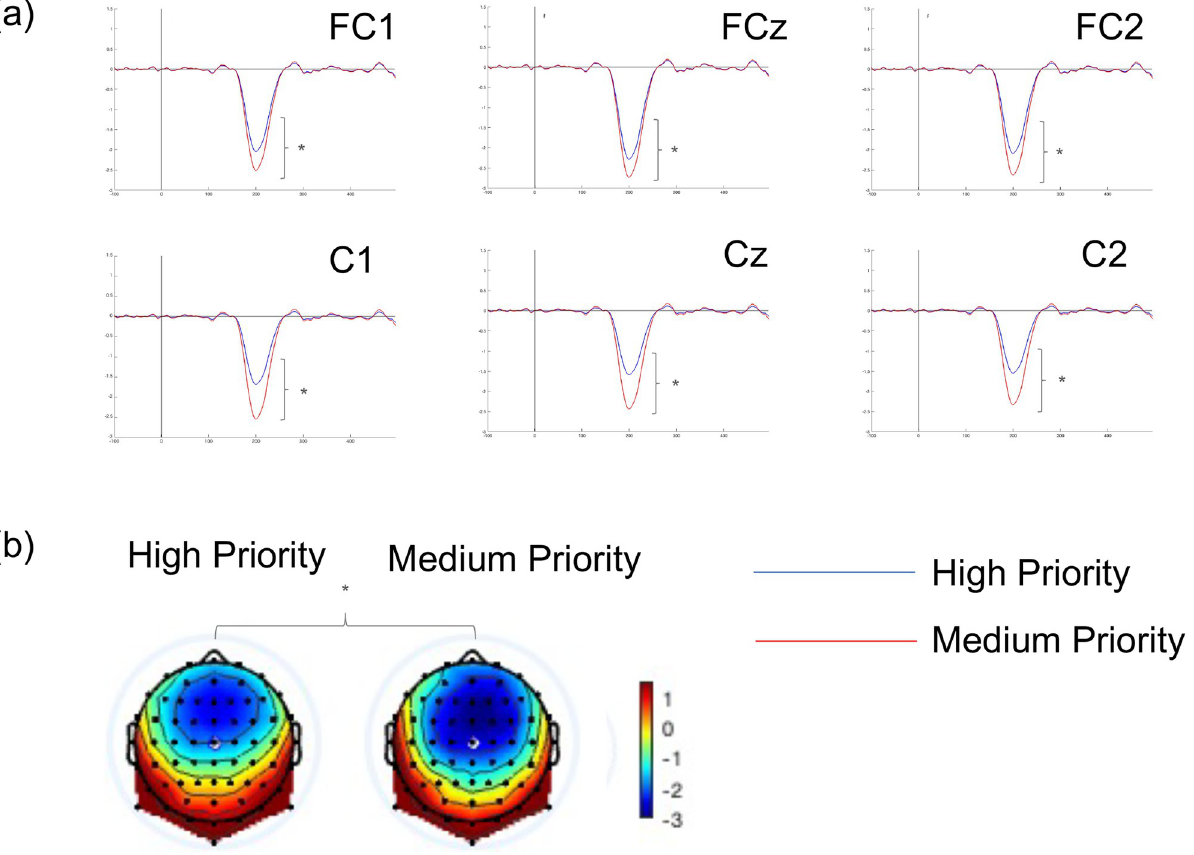
Fig 7. (a) MMN (TF03) waves for high priority (blue lines) and medium priority (red lines) pulses of the fronto-central and central regions; and (b) voltage topographical distributions to the peak of the MMN (198 ms) in response to the high priority and medium priority pulses ( � p < .05).